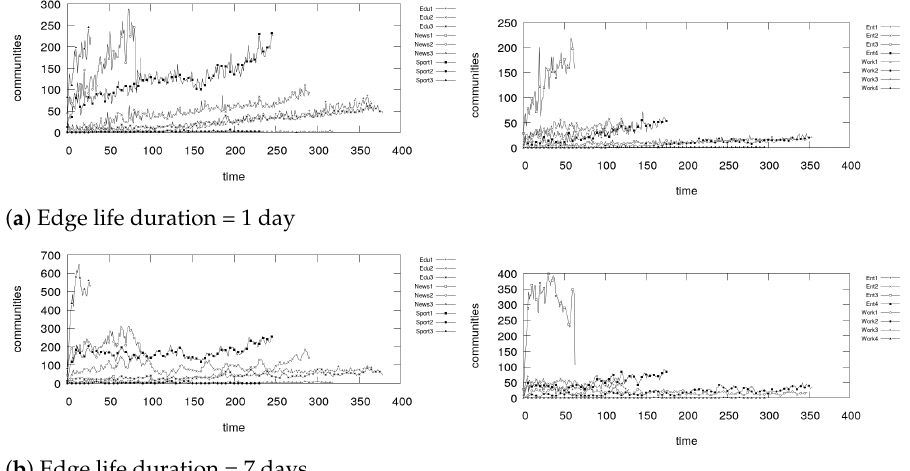
Figure 8. Number of communities detected by TILES.